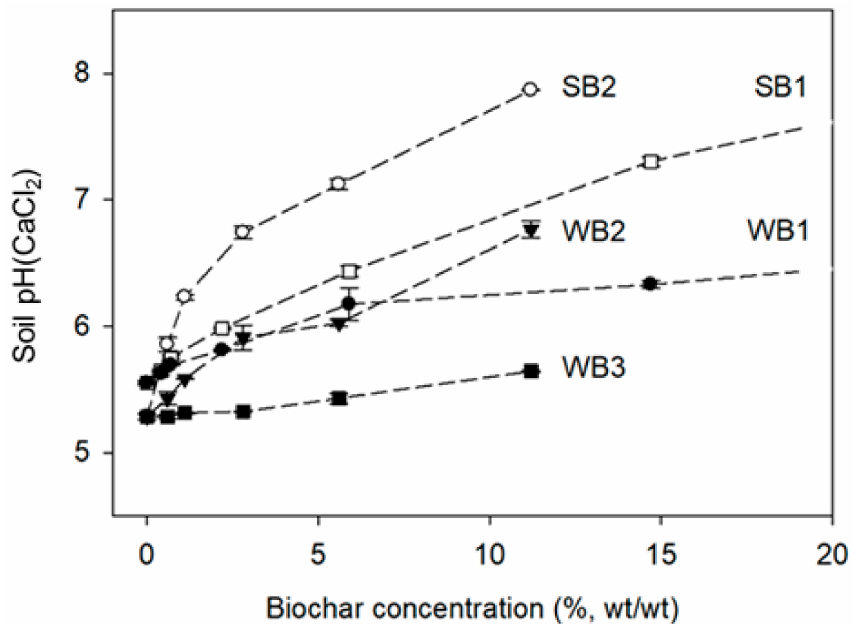
Figure 3. Effect of biochar concentration on soil pH after ≥ 1 week of soil/biochar interaction. Data are means ± standard error ( n = 2–3). SB1, SB2—straw biochars; WB1, WB2—pine wood biochars; WB3—oak wood biochar. Soil pH of 8.6 and 6.8 was measured at biochar concentrations of 37% for SB1 and WB1, respectively (data not shown).